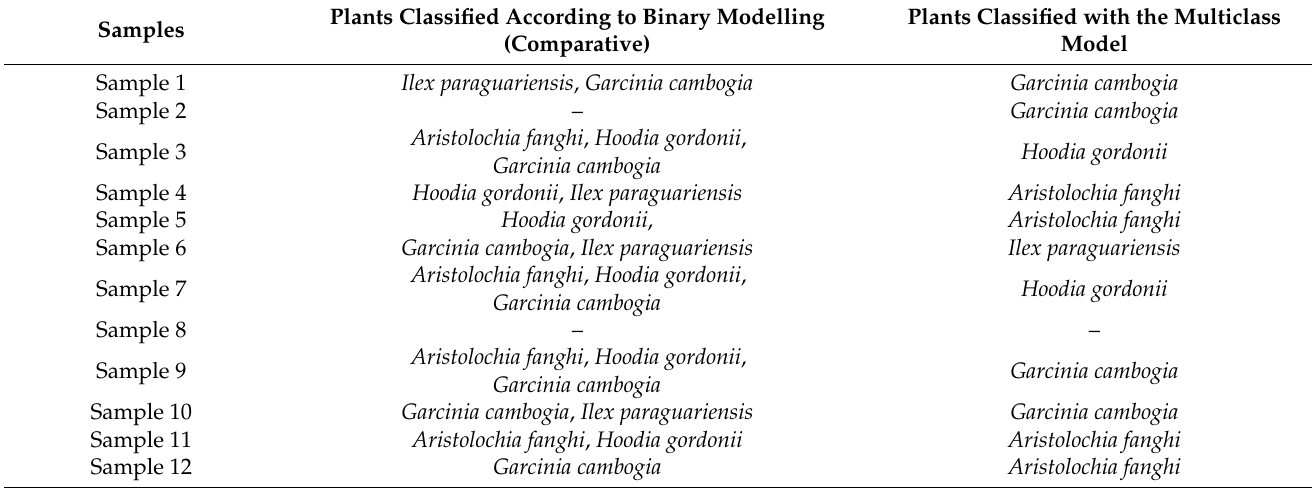
Table 7. Depiction of obtained predicted samples by comparing binary modelling for the four plants and multiclass model based on the selected wavelengths for Aristolochia fanghi